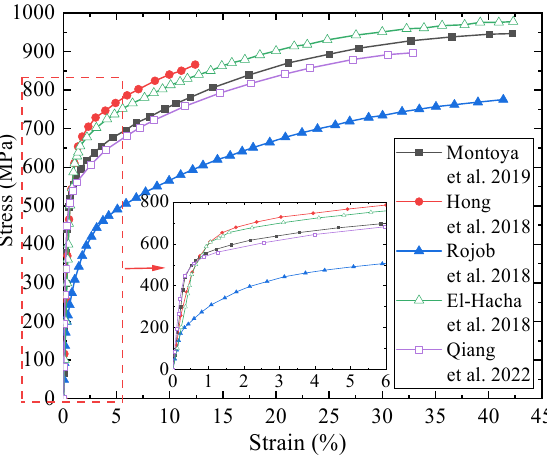
Table 3. Physical parameters of Fe-SMA, steel, and concrete [32,74–76].